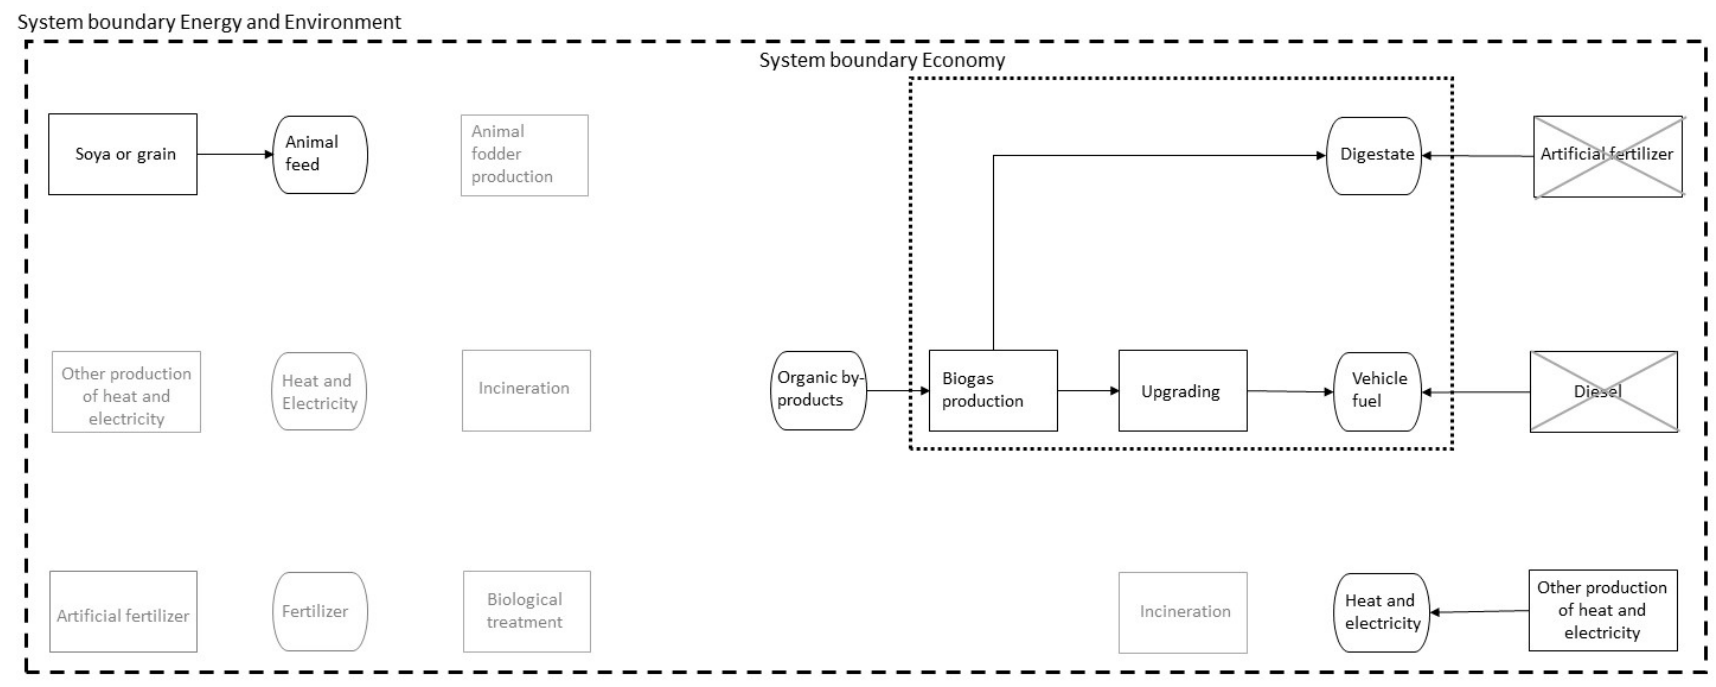
Figure 3. An example of a system studied including the system expansion [4]. Methods in grey are not included in the analysis. These methods are included in some of the other scenarios in Lindkvist et al. [4]. Alternative production methods with a cross are inactive. The dotted line shows the system boundaries.